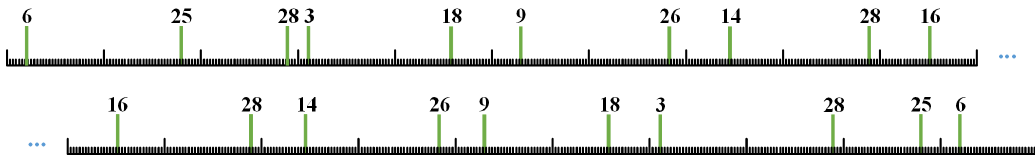
Figure 4. Frame acquisition sequence.